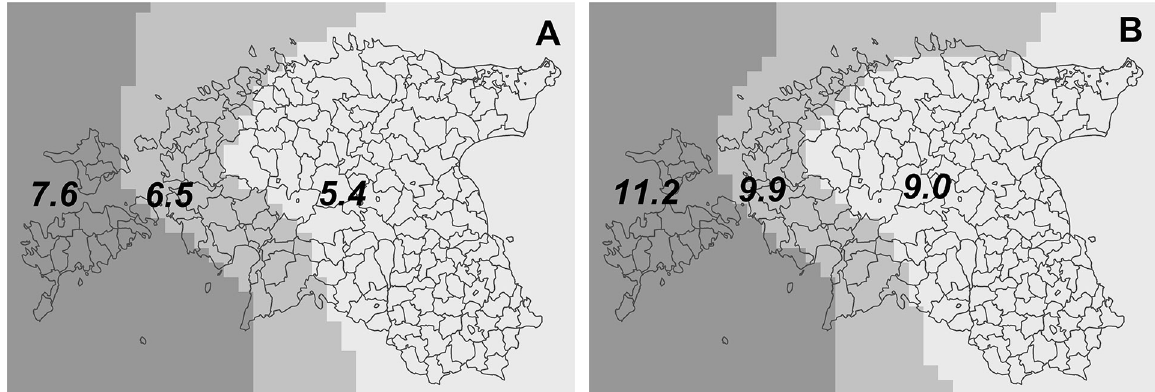
Fig. 5. Autumn (SON) air temperature (°C) regions and their average air temperature during the reference period 1971–2000 ( A ) and according to RCP8.5 for the period 2071–2100 ( B